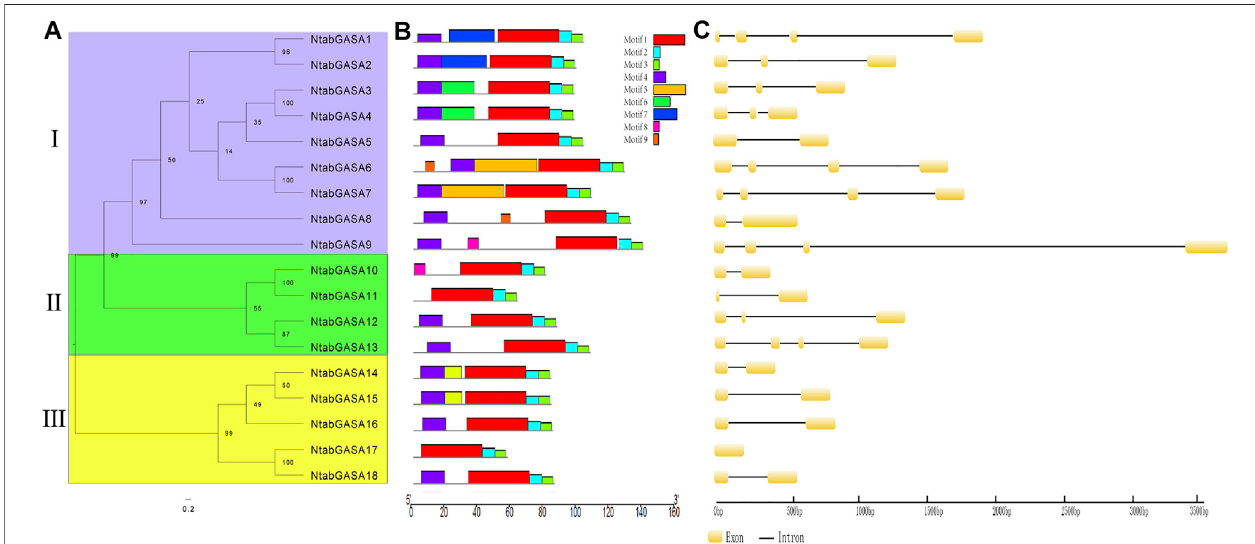
FIGURE 4 | Phylogenetic relationship, conserved motifs of NtGASA proteins and exon – intron structures of NtGASA genes. (A) An unrooted phylogenetic tree constructed based on NtGASA protein sequences, different colors indicate different subgroups. (B) Conserved motifs in the NtGASA proteins. The conserved motifs were identi fi ed using MEME with complete protein sequences. Different motifs were displayed by various colors. (C) Exon – intron distribution of NtGASA